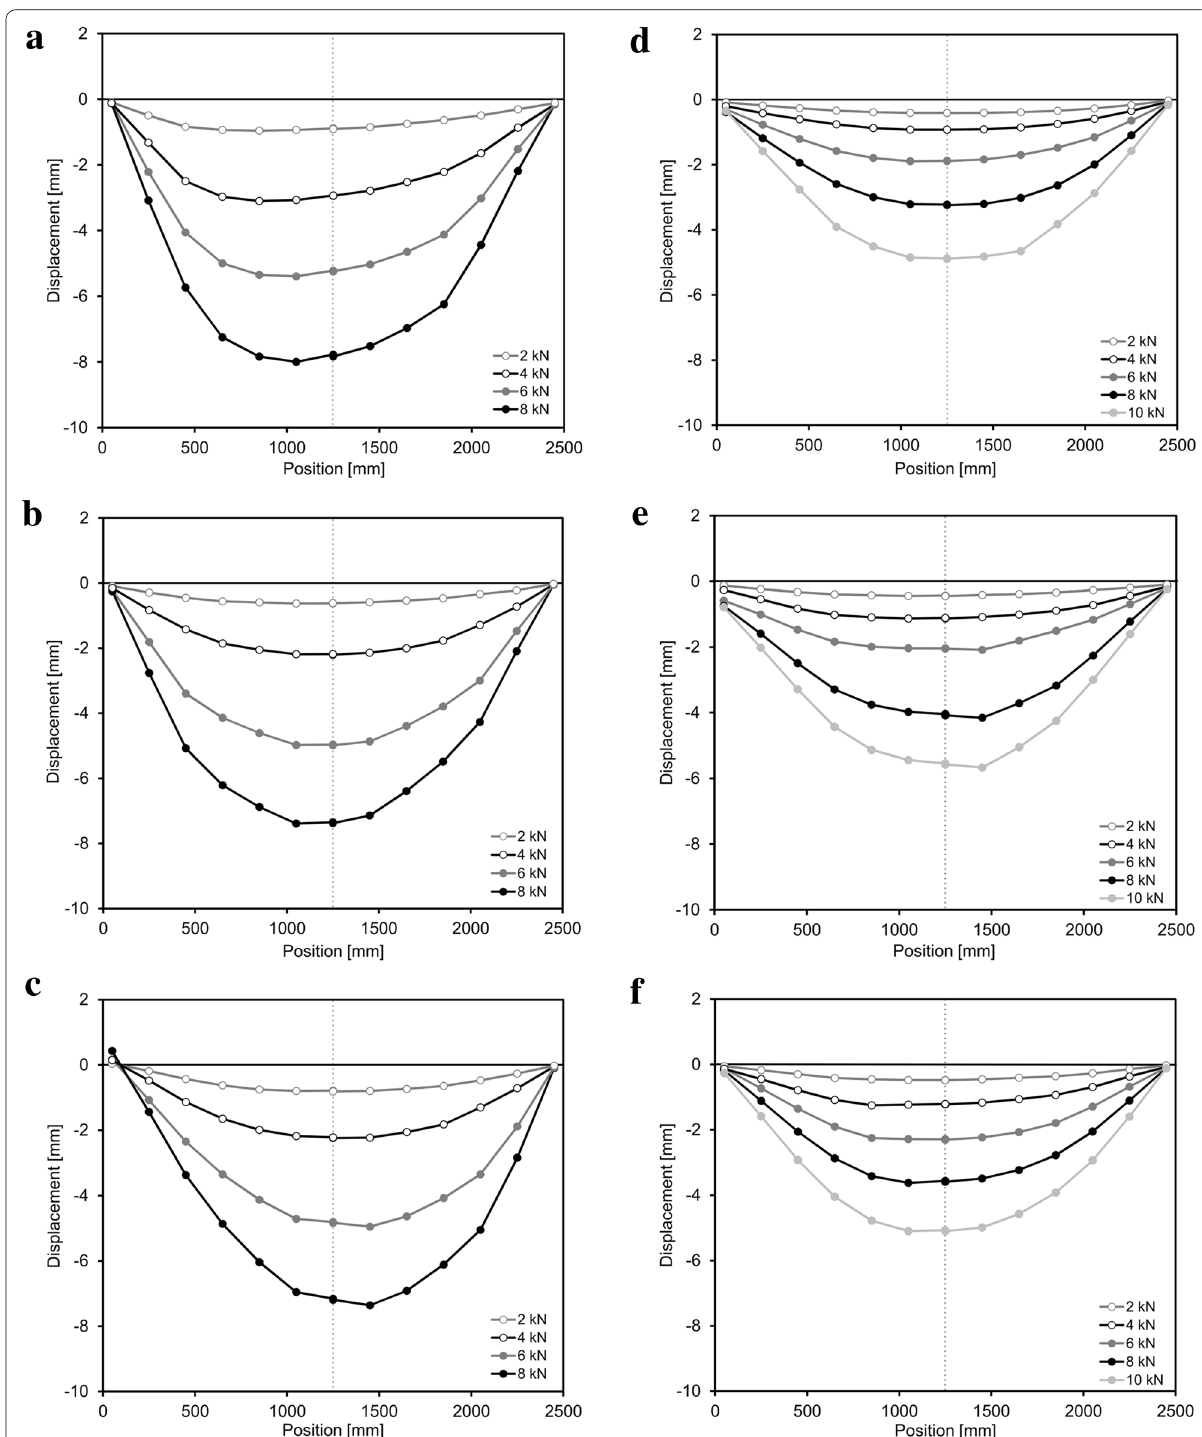
Fig. 12 Deflection shape of the lower panel at different load levels for specimens; a S-1, b S-2, c S-3, d D-1, e D-2 and f